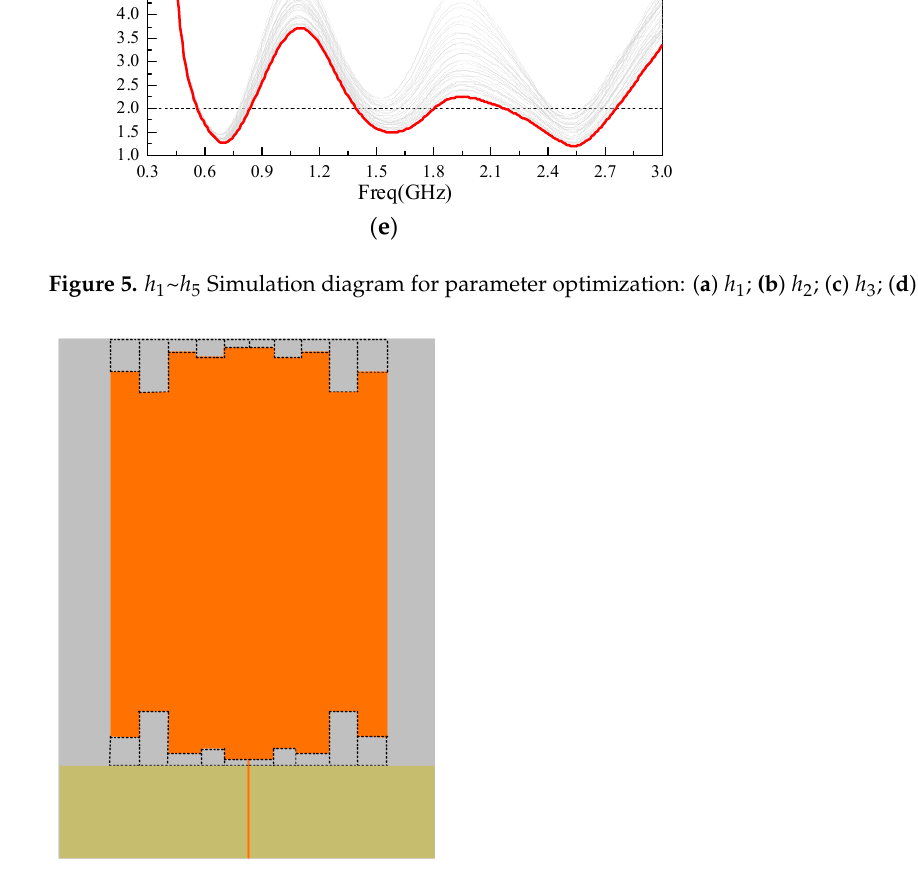
Figure 6. Model diagram of improved monopole